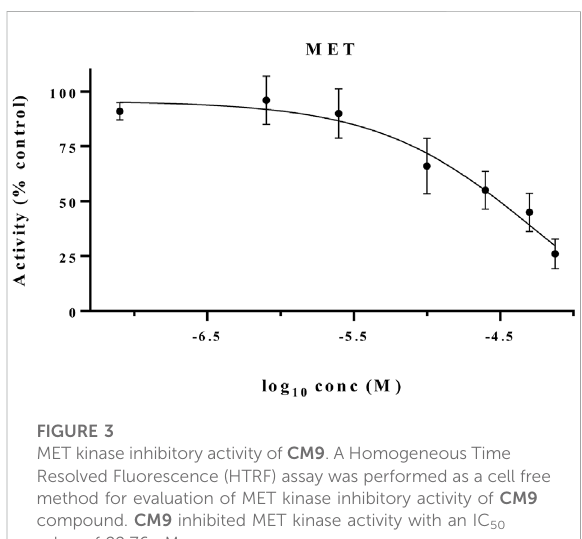
FIGURE 3 MET kinase inhibitory activity of CM9 . A Homogeneous Time Resolved Fluorescence (HTRF) assay was performed as a cell free method for evaluation of MET kinase inhibitory activity of CM9 compound. CM9 inhibited MET kinase activity with an IC 50 value of 22.76